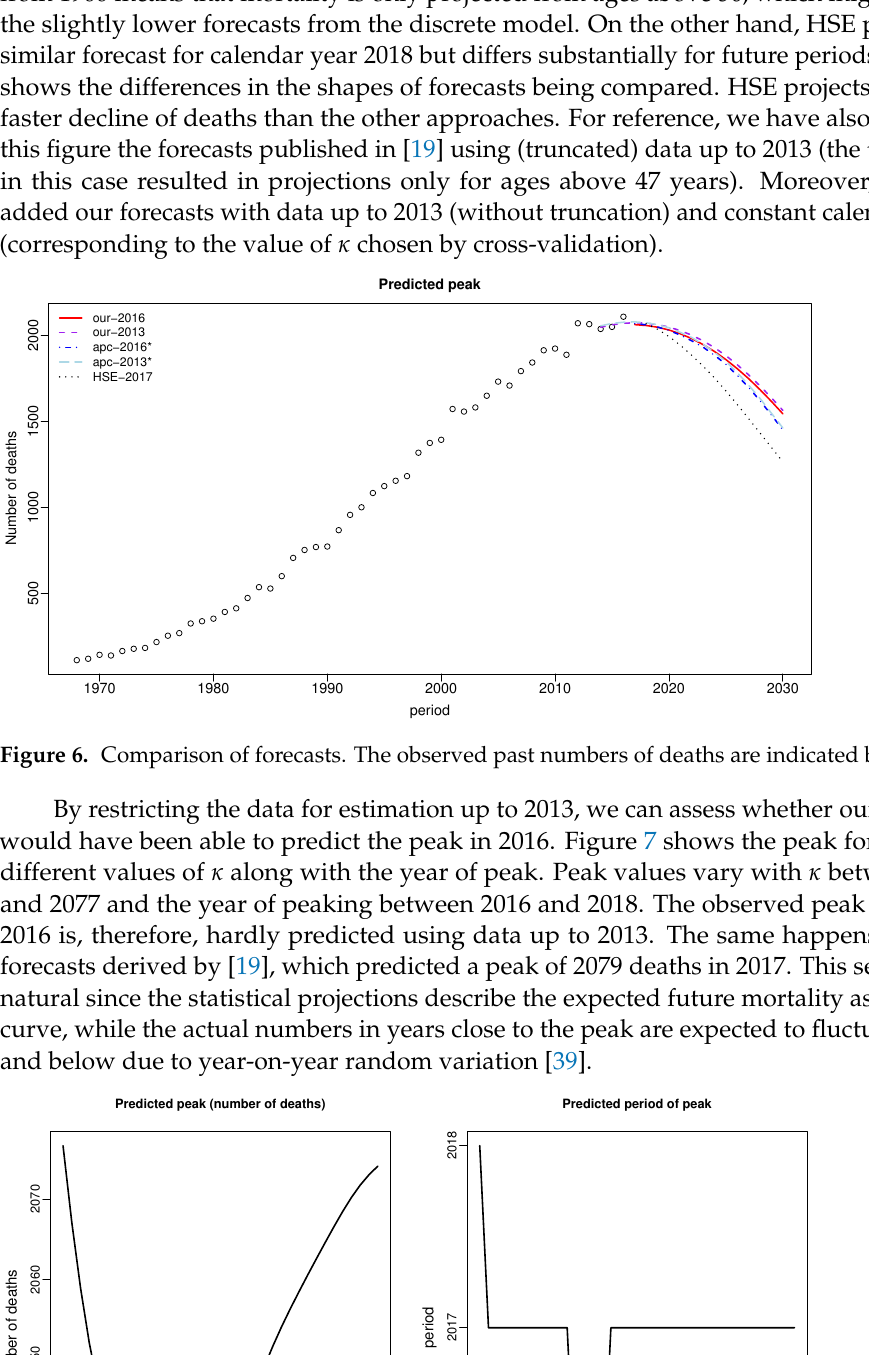
Figure 7. Peak forecasts ( left ) and year of peak ( right ) for different values of κ . Based on data up to